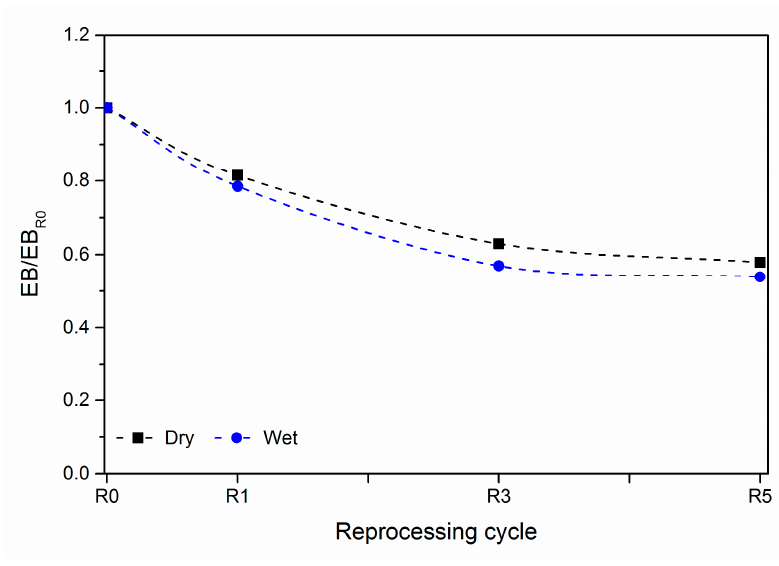
Figure 7. Dimensionless elongation at break as a function of the reprocessing cycles.